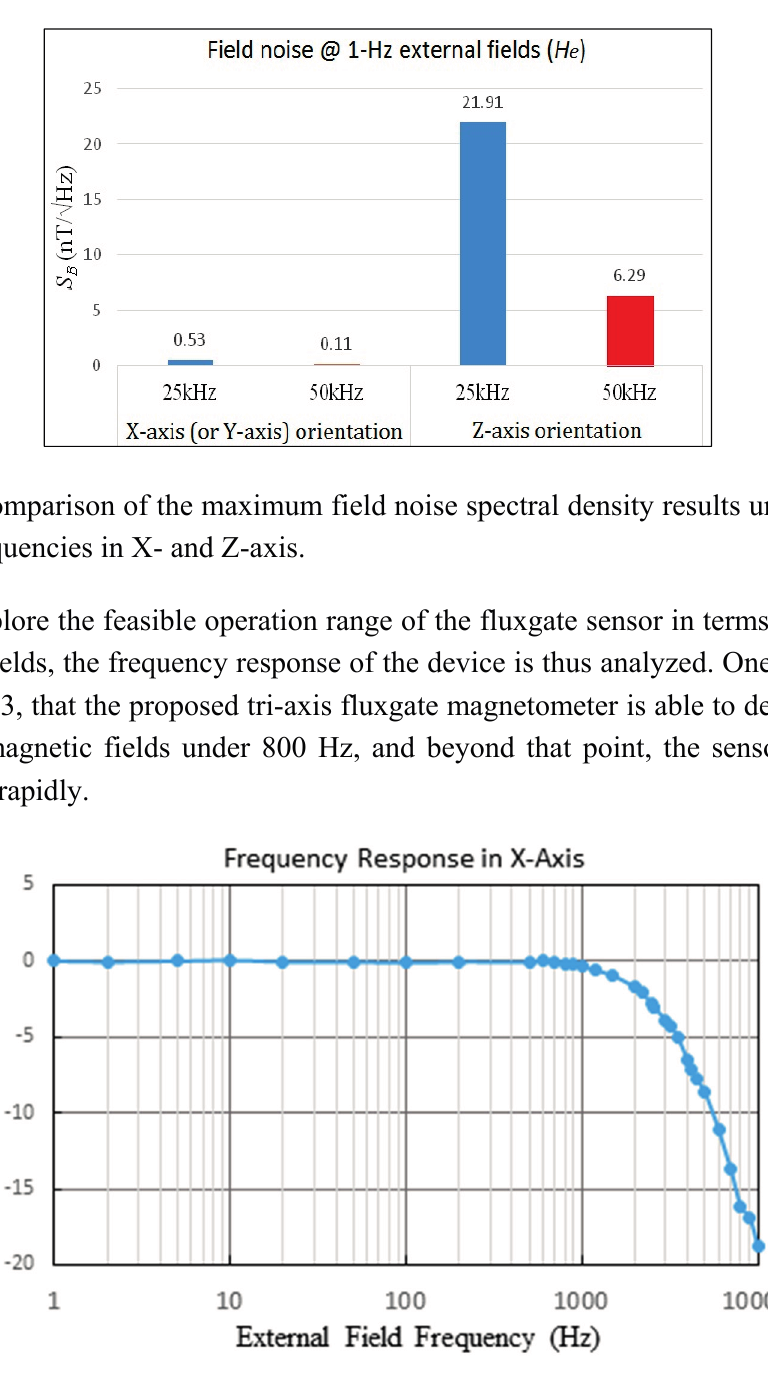
Figure 13. The frequency response result of the fluxgate with regard to the external field